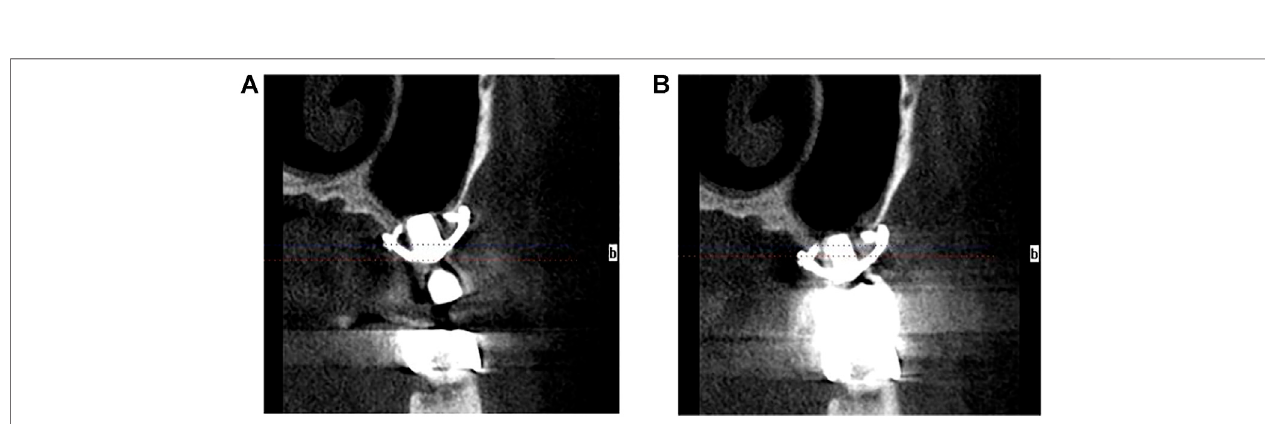
FIGURE 7 | The CBCT images. (A) 6-month postoperative CBCT image. (B) 12-month postoperative CBCT image.